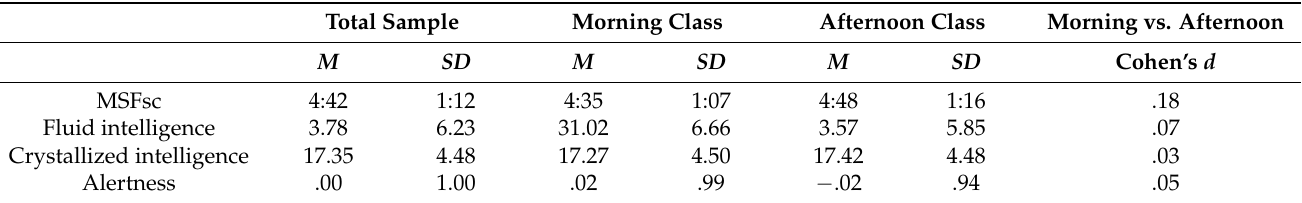
Table 1. Descriptive statistics of the study variables for the total sample and morning versus afternoon classes (no significant differences were noted). Morning Class